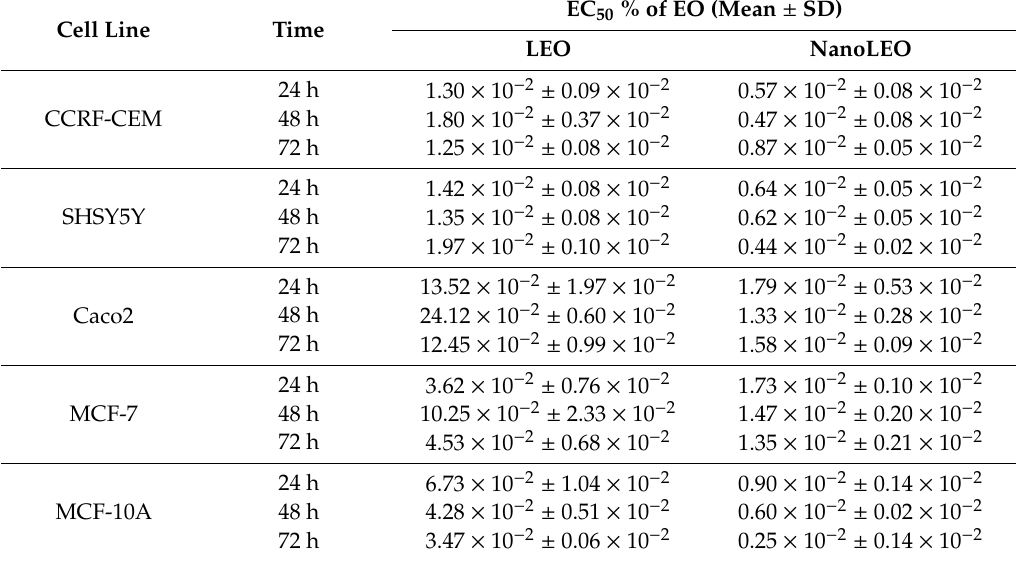
Table 2. LEO and NanoLEO EC 50 values obtained by dose-dependent MTT ((3-(4,5-Dimethylthiazol- 2-yl)-2,5-Diphenyltetrazolium Bromide) assay after 24, 48 and 72 h of treatments. The values are expressed as mean ± SD. Vinblastine was used as positive control 1 . p < 0.05 according to ANOVA test.